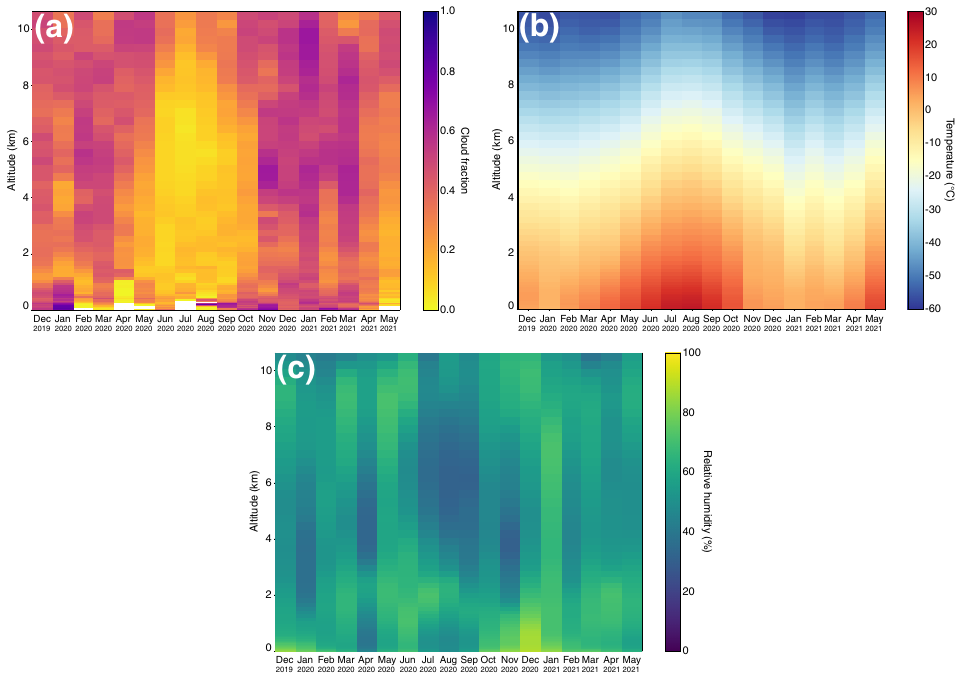
Figure 7. ECMWF − IFS monthly averages for ( a ) cloud fraction ( > 0.01), ( b ) temperature ( ◦ C), and ( c ) relative humidity (%) over MARS from December 2019 to May